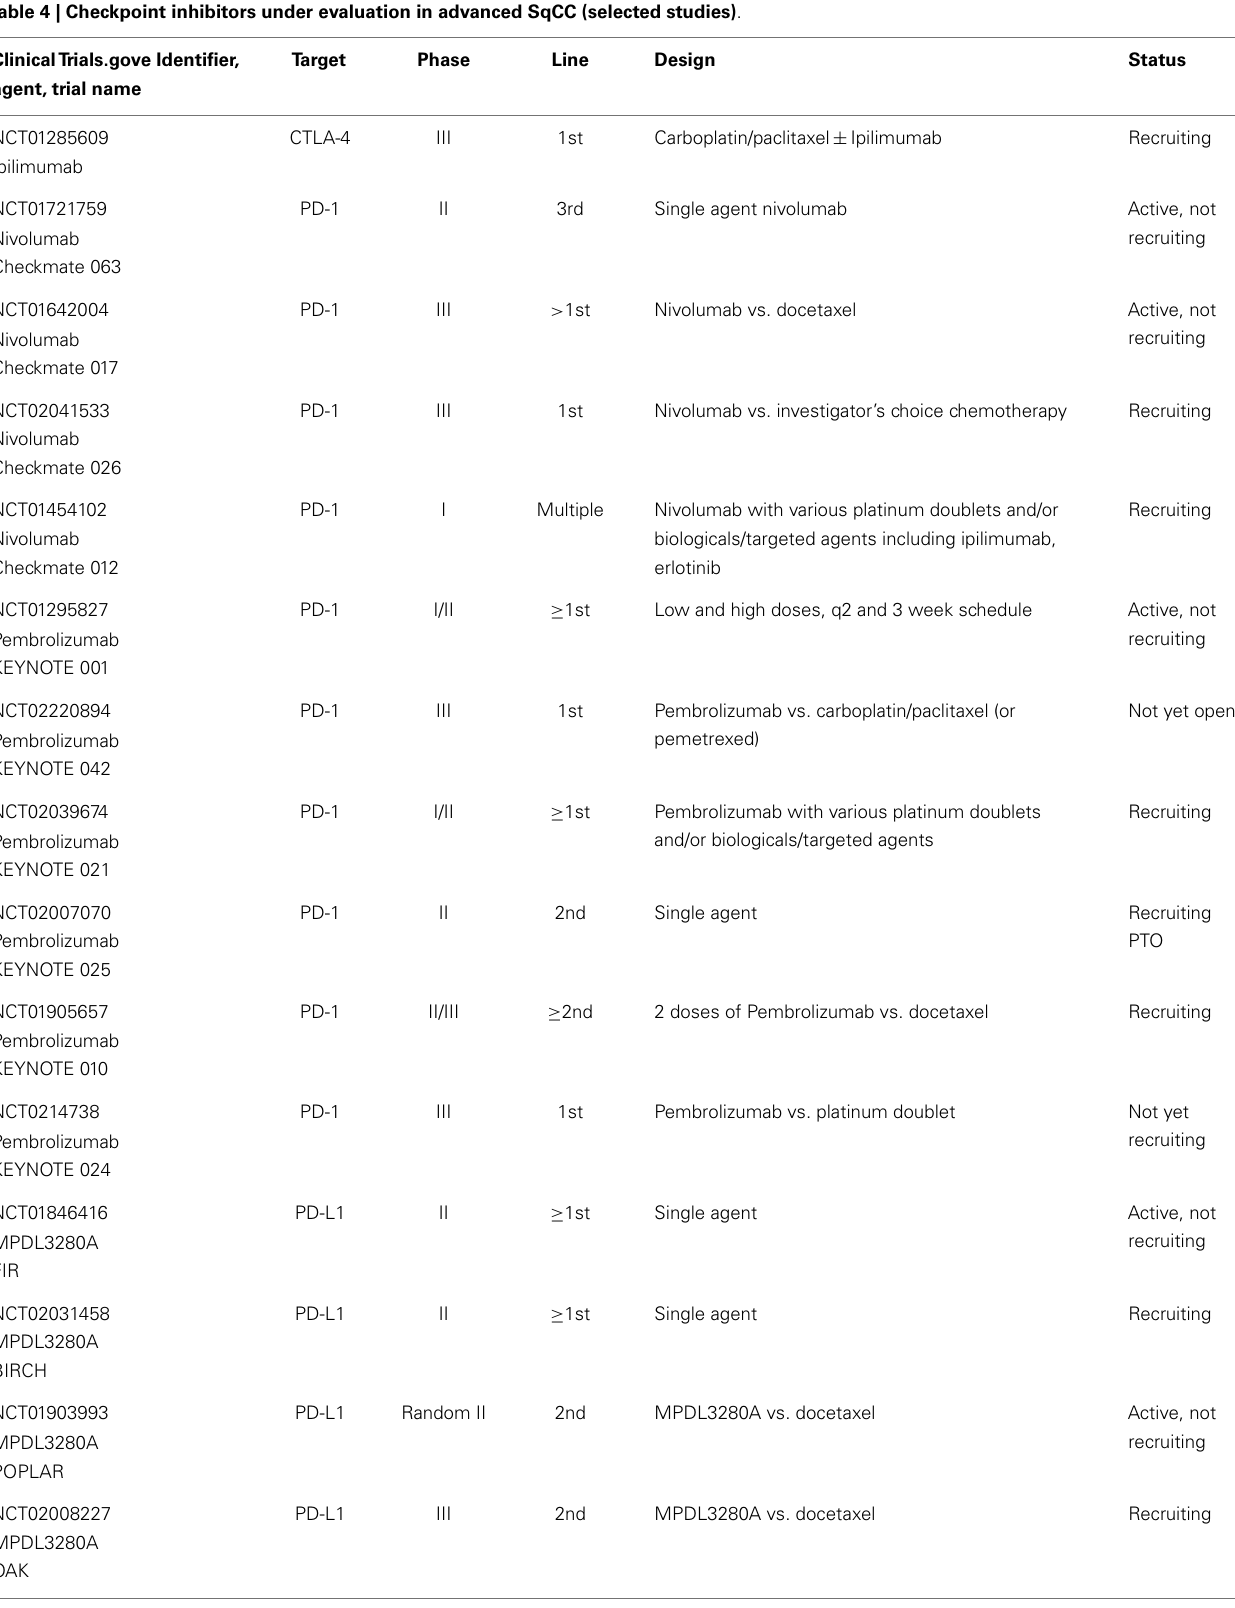
Table 4 | Checkpoint inhibitors under evaluation in advanced SqCC (selected studies) . ClinicalTrials.gove